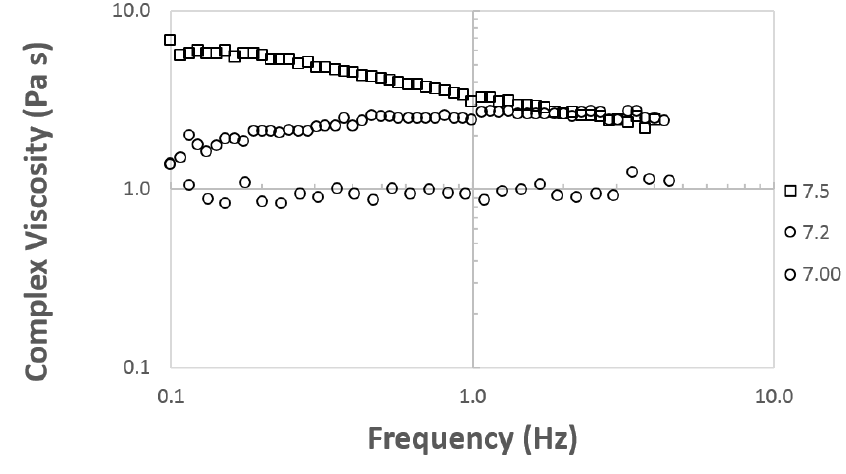
Figure 5. Complex viscosity data measured in a frequency sweep (0.1–10 Hz).